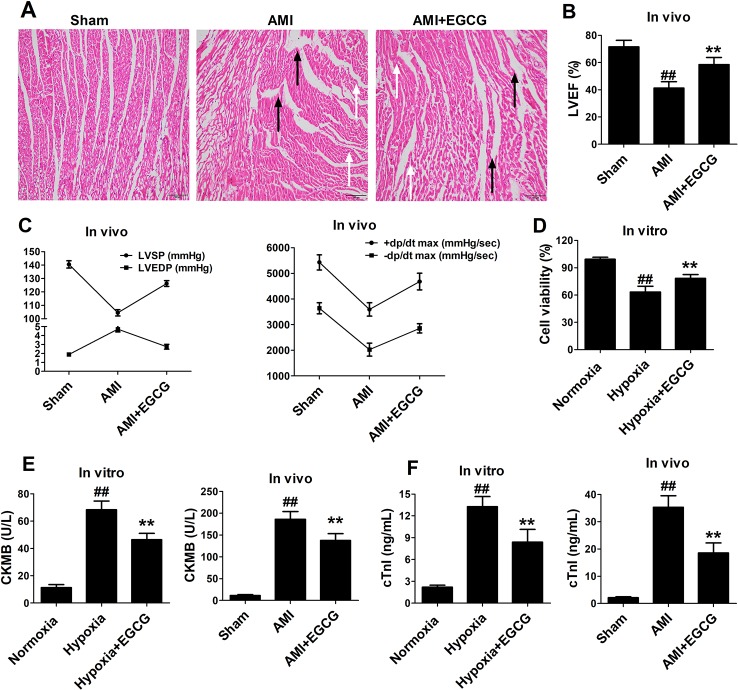
EGCG promoted recovery of cardiac dysfunction and attenuated cell damage. (A) Representative images of H&E-stained sections. Black arrow stands for infarct area, white arrow stands for border zone areas. (B) Left ventricular ejection fraction (LVEF). (C) Left ventricular systolic pressure (LVSP) and Left ventricular end-diastolic pressure (LVEDP), +dp/dt max and −dp/dt max. (D) Cell viability was determined by CCK-8 assay. (E–F) ELISA was performed to determine the expression levels of CK-MB, and cTnI myocardial injury markers in cell culture supernatant and serum. The data are presented as the means ± SD (n = 6 per group). ANOVA testing was performed; ##
p < 0.01 vs. sham (normoxia) group; **p < 0.01 vs. AMI (hypoxia) group.